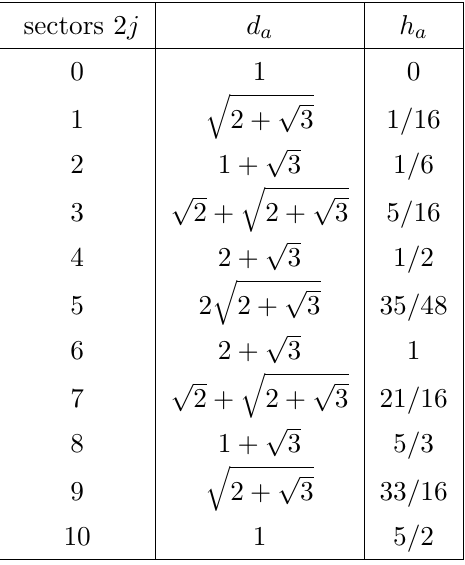
Table 5 . su (2) 10 topological sectors, quantum dimensions, and topological spins. The label j gives the SU(2) spins of these